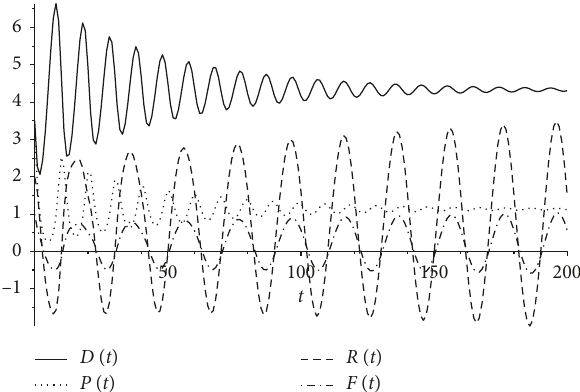
Figure 9: Numerical simulation diagram of system (2) when � 0 . 5 , τ � 8 . τ 1 2